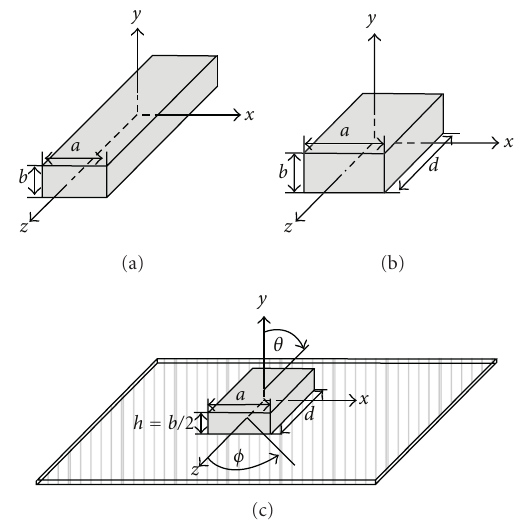
Figure 3: Waveguide modeled as a